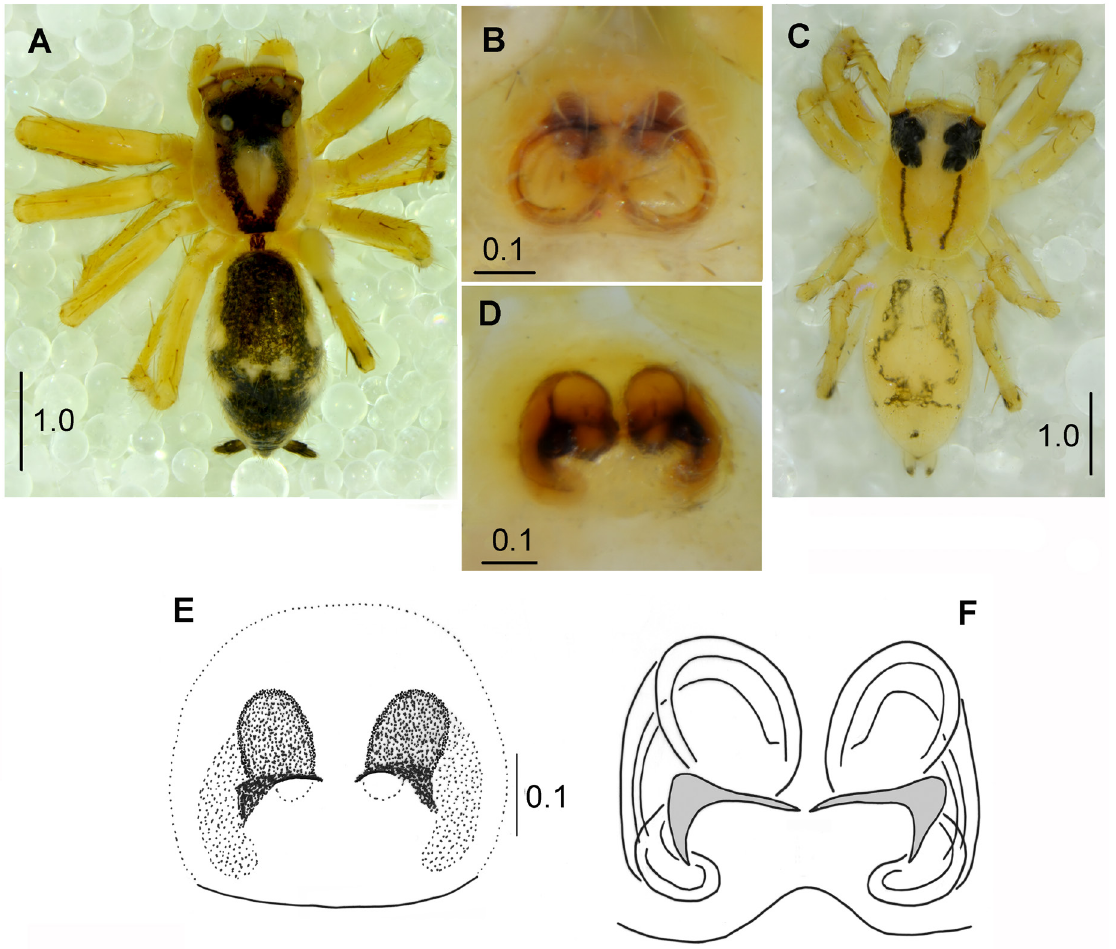
Fig. 5. A–B . Asemonea pulchra Berland & Millot, 1941,♀ (MNHN). C–F . Asemonea pusilla sp. nov., paratype, ♀ (MNHN). A, C . Habitus, dorsal view. B, D–E . Epigyne. F . Internal structure of